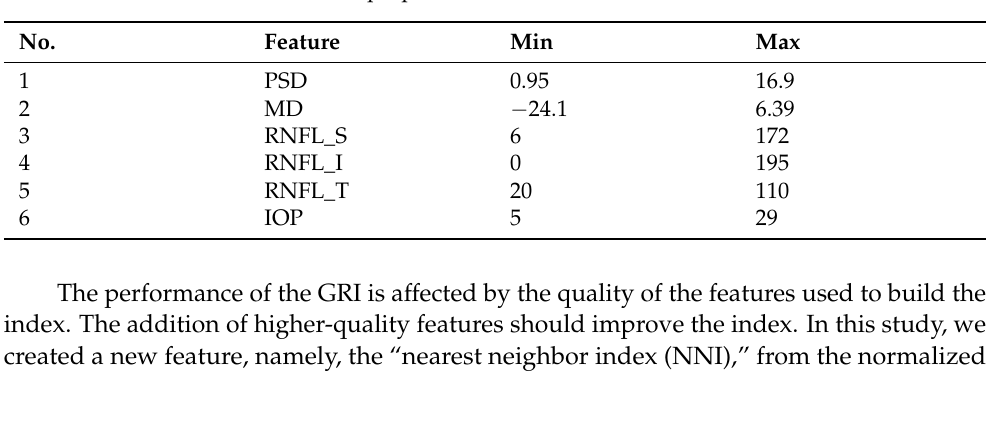
Table 6. Min and max values for the proposed